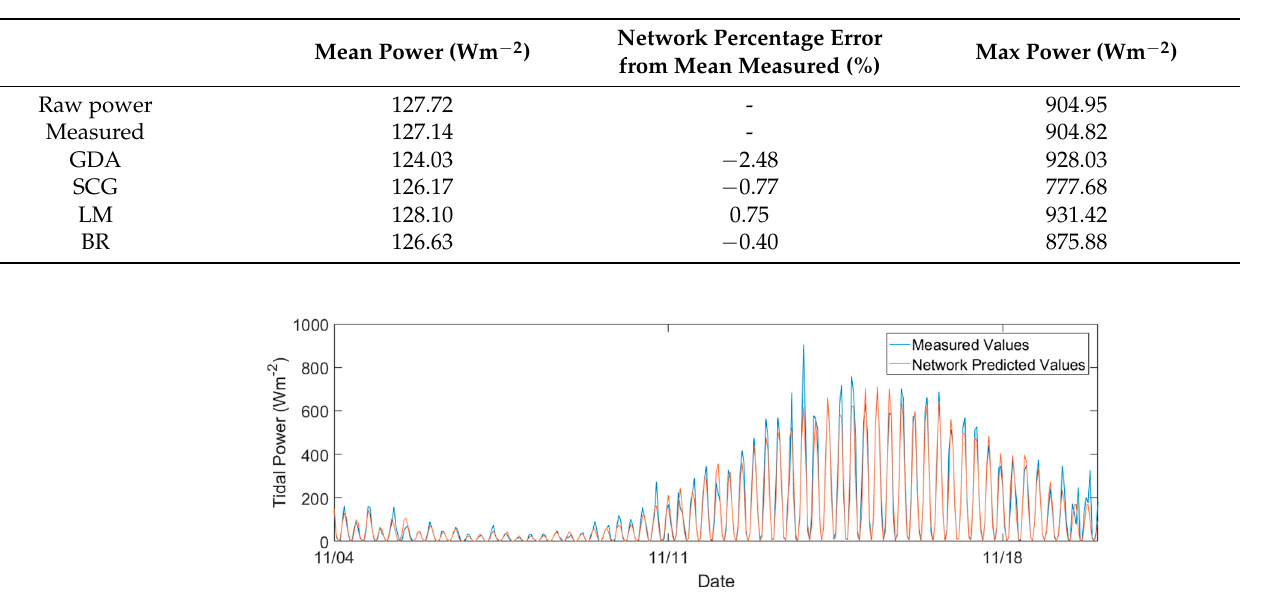
Table 4. Measured mean power before accounting for the angle of current (raw power), consider- ing incident angle (measured), and each training method’s best-performing networks prediction of mean power and error.